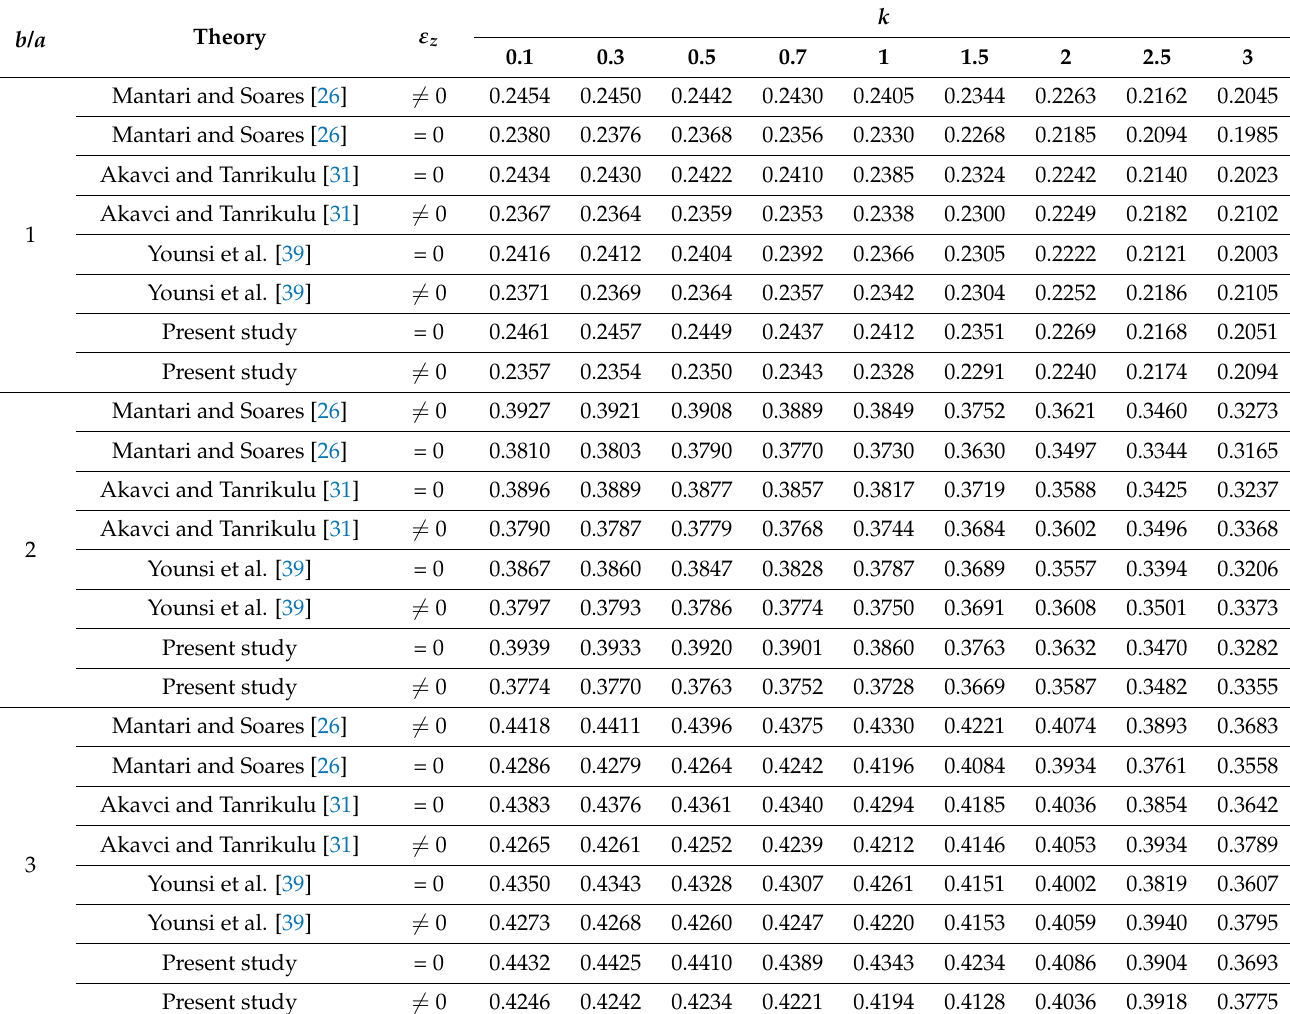
Table 6. Non-dimensional stress τ xz ( 0 ) = h distributed load ( a / h =